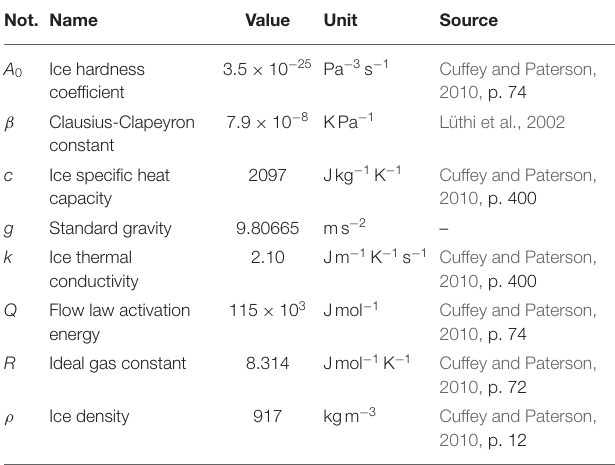
TABLE 3 | Parameter values used to compute the theoretical englacial warming. Figure 4a , gray lines) depict temperatures incompatible with those recorded by digital inclinometers in the same hole (BH3, Figure 4a , green lines), whose depths were calibrated using independent pressure